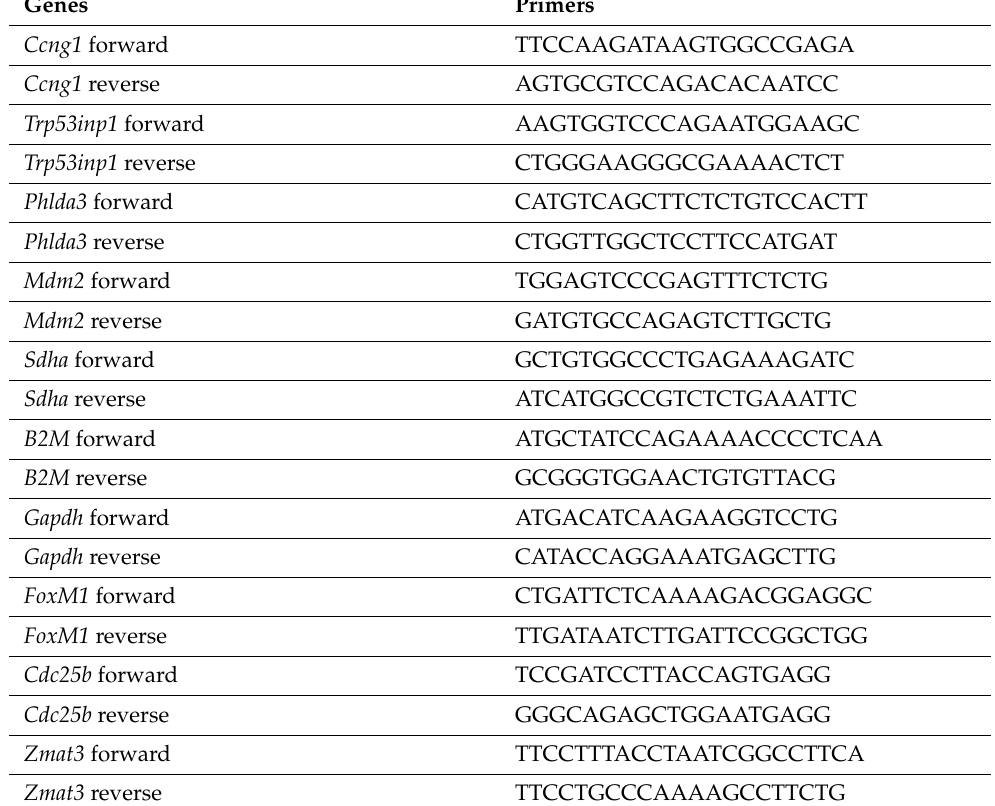
Table 1. Primers used for